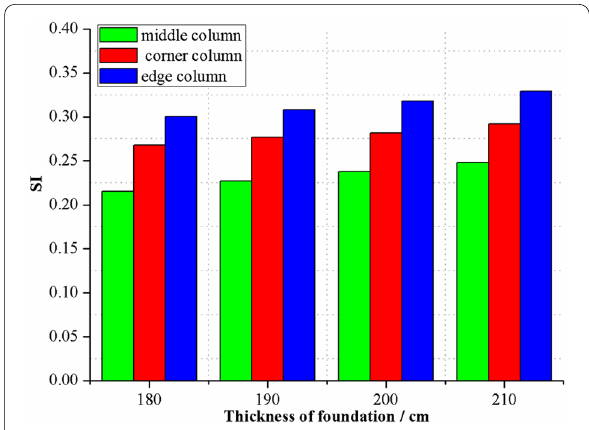
Fig. 9 The plot of the sensitivity index versus the thickness of